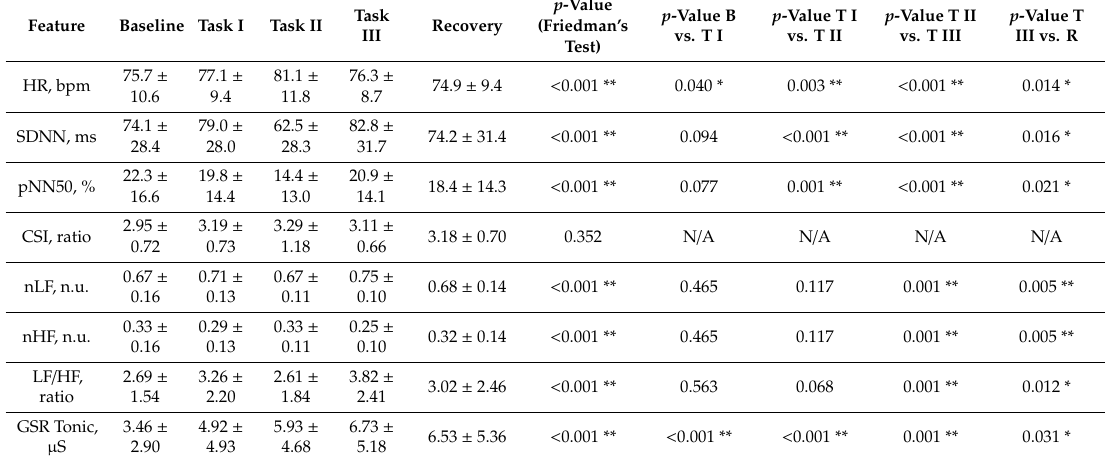
Table 2. Autonomic parameters in the di ff erent phases indicated as mean ± standard deviation